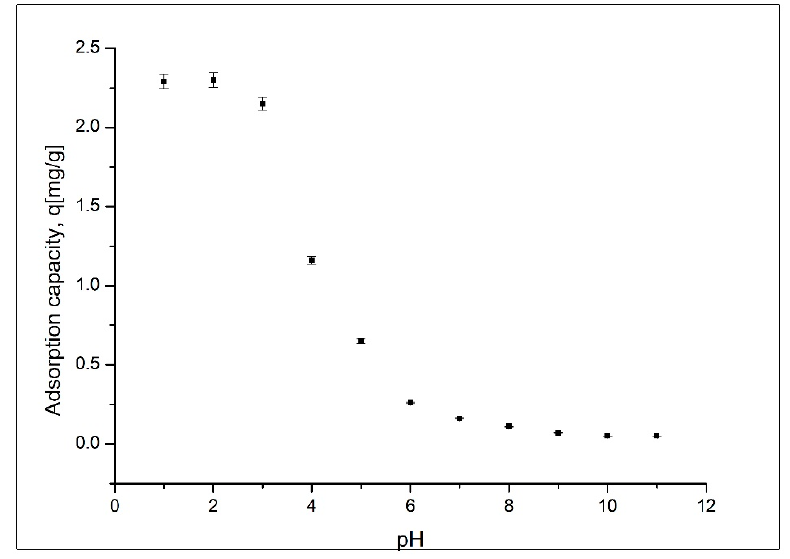
Figure 4. Confocal laser scanning microscopy, CLSM.